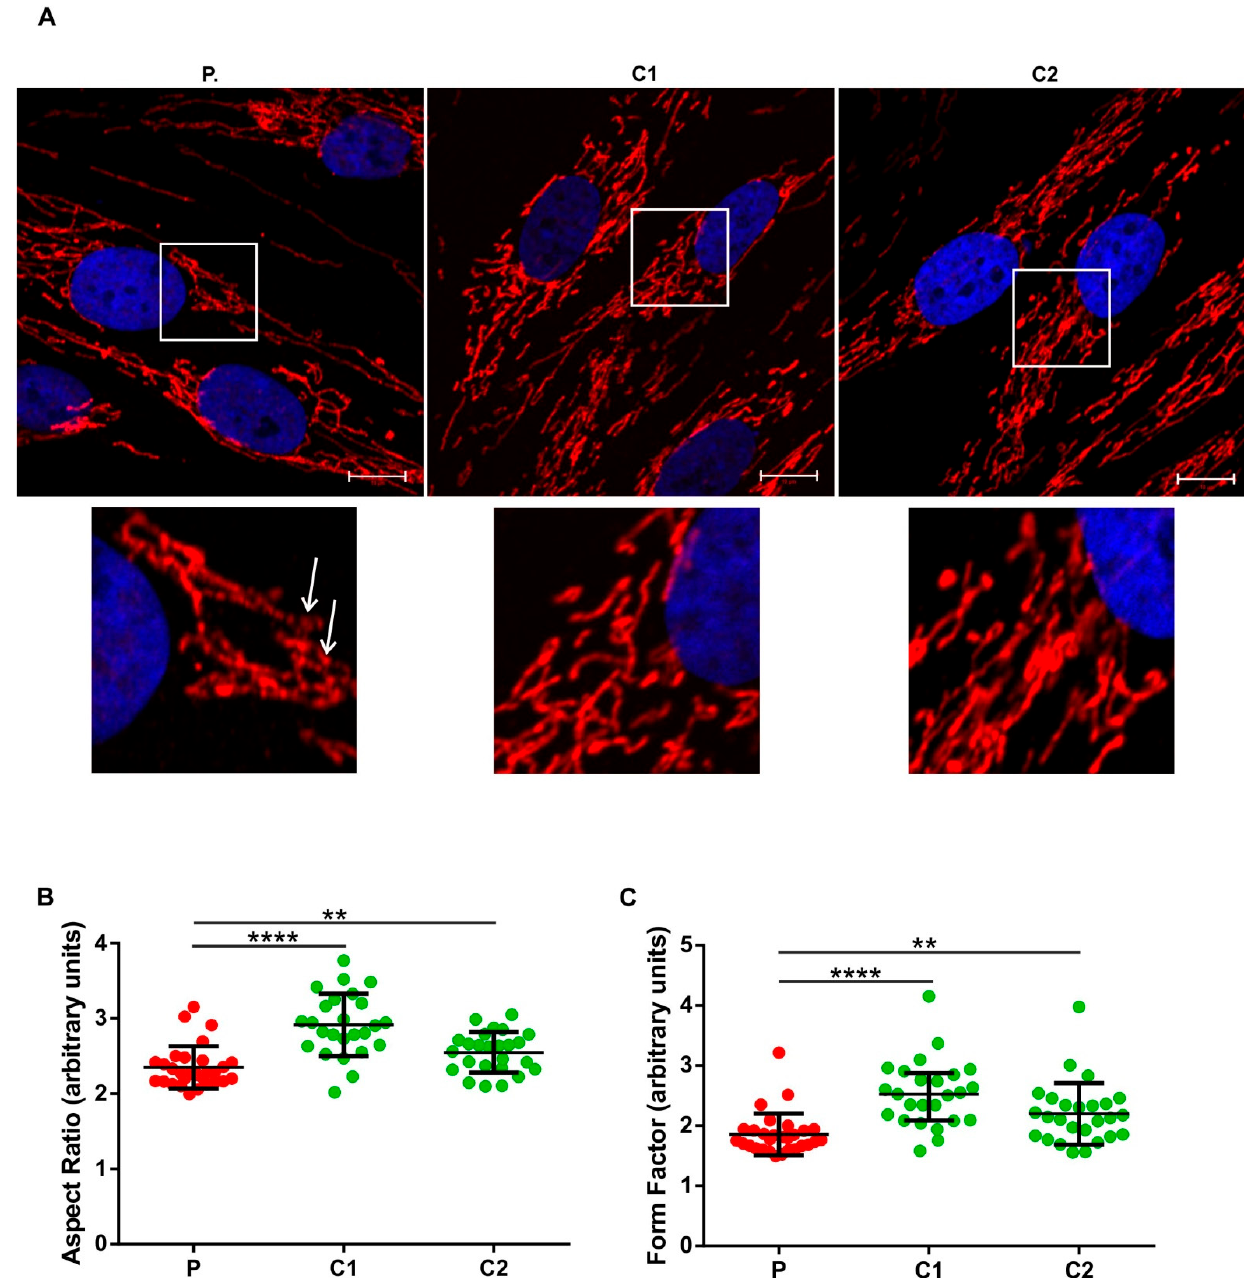
Figure 3. ( A ) The mitochondrial network in the patient’s fibroblasts (P) compared to neurologically healthy, age-matched controls (C1, C2). Area delineated with the white square in the upper panel is enlarged in the lower panel. White arrows point to round, fragmented mitochondria. Red: Hsp60—mitochondria, blue: DAPI—nucleus; representative images are shown; ( B ) decreased form factor and ( C ) decreased Aspect Ratio in the patient’s mitochondria compared to controls. Aspect Ratio < 0.0001, Kruskal–Wallis test; Form Factor < 0.0001, Kruskal–Wallis test; P for differences between individual cell lines: P vs. C1, P vs. C2 were calculated with unpaired t test with Welch’s correction, **** < 0.0001, ** < 0.01. All images were taken at 63× magnification. Each dot corresponds to a measurement from one cell. Upper panel scale bar = 10 µm.